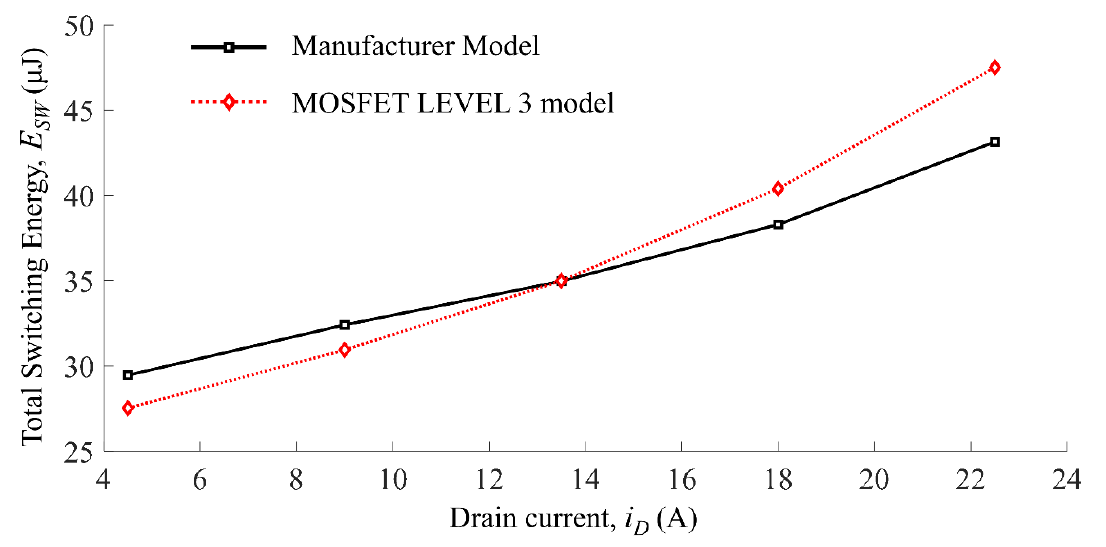
Figure 10. Comparison of total switching energy losses for different drain